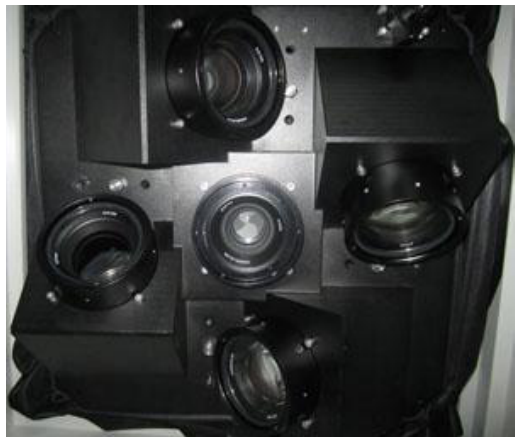
Figure 2. SWDC-5 imaging